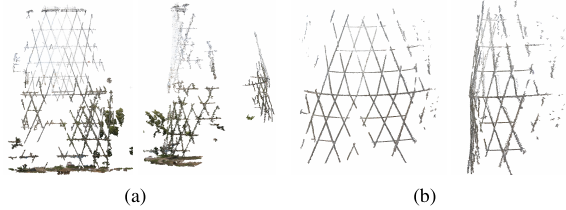
Figure 5. Dense point cloud (3.3 mil points) produced on a set of images without applying any masking (a). Dense point cloud (2.1 mil points) derived applying a masking (b).